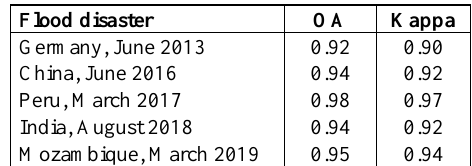
Table 2. Accuracy assessment for different flood